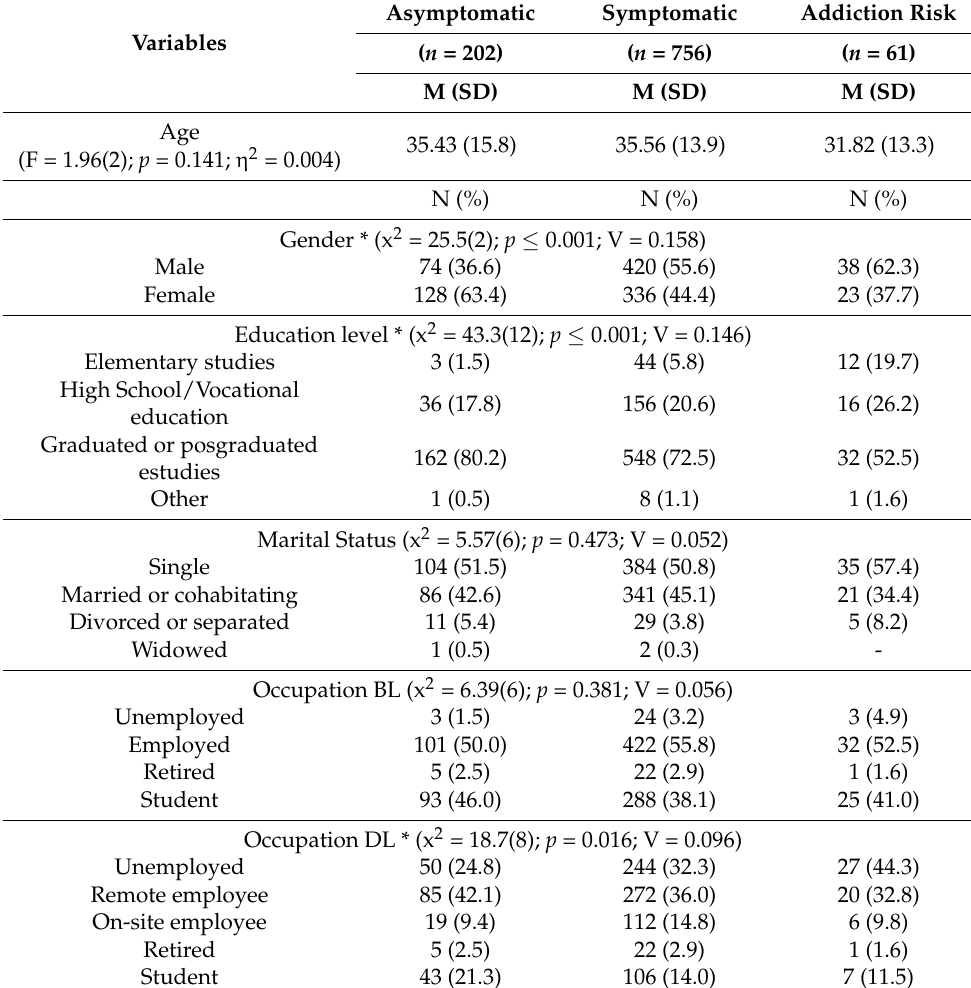
Table 1. Sociodemographic profile of the participants by addiction